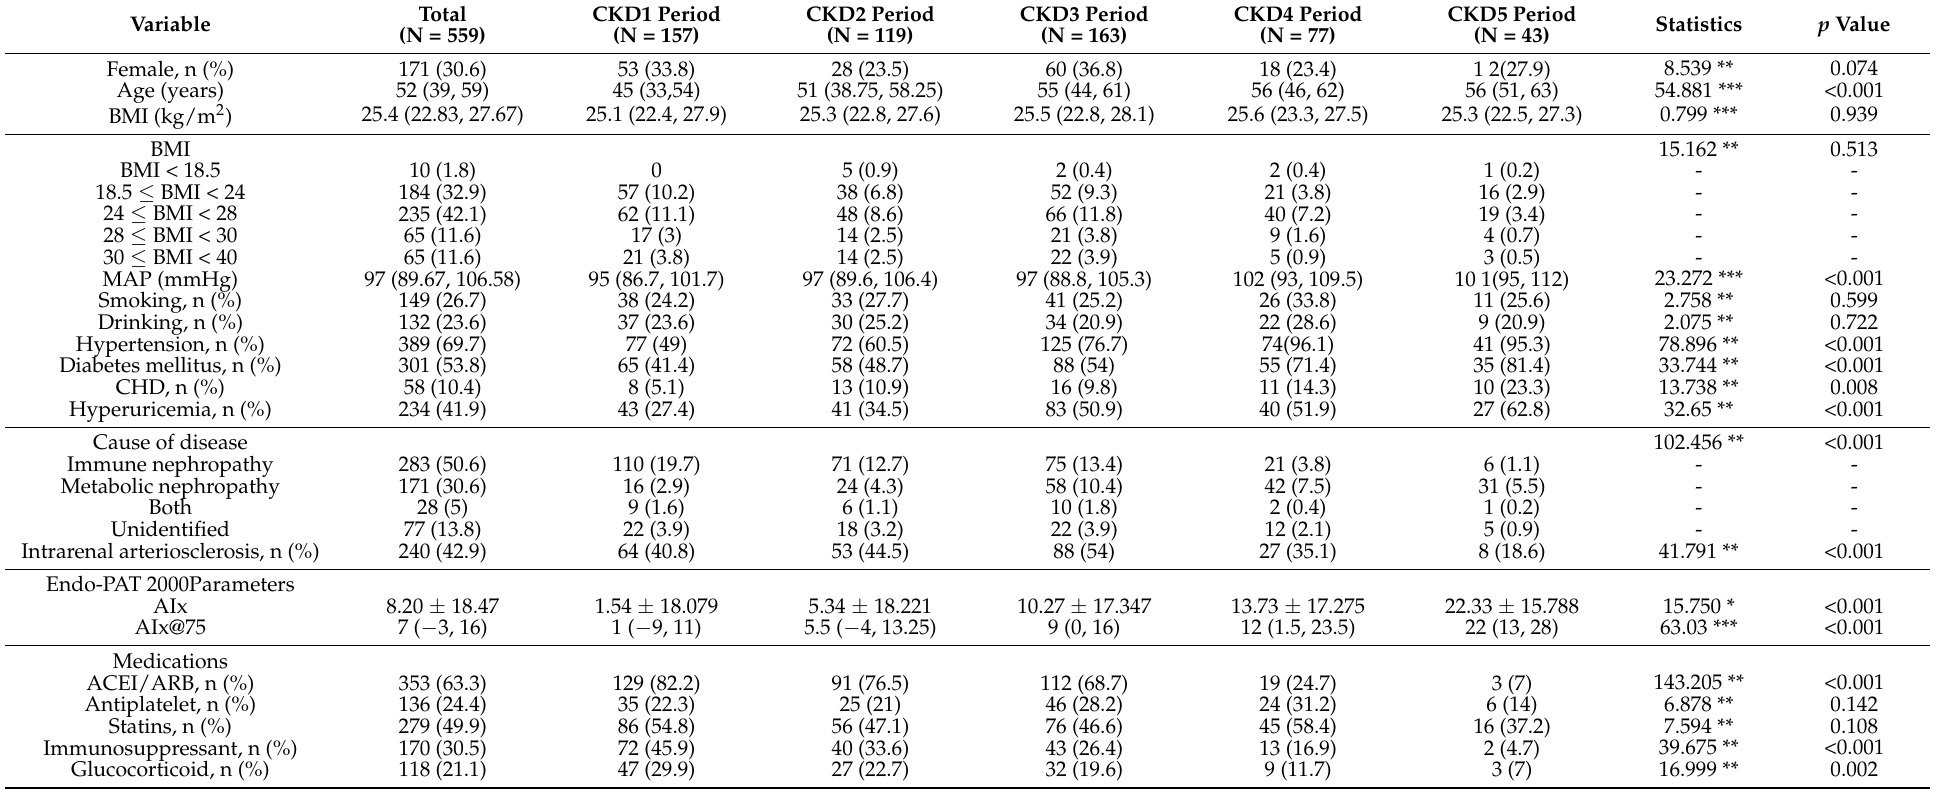
Table 1. Demographic characteristics of the